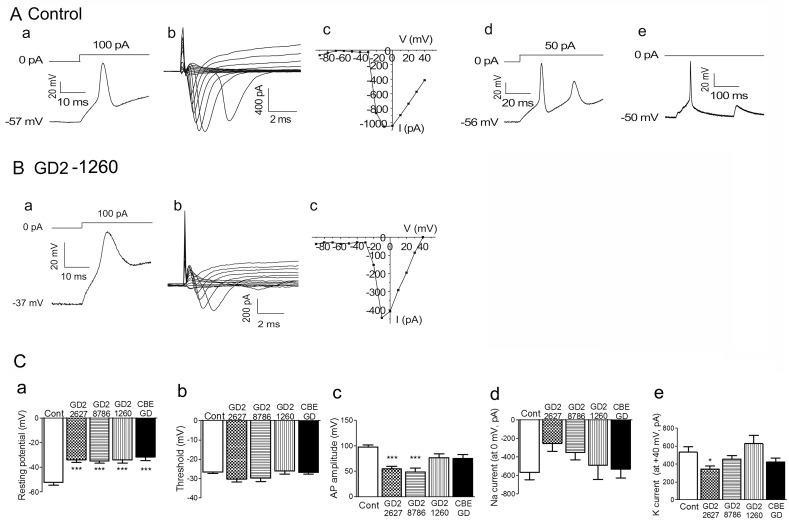
Electrophysiology of iPSC-derived neurons (14 d).(A) Action potential firing and voltage-gated sodium channels in control neurons. Control iPSC-derived neurons could fire a single action potential with membrane potential -57mV (a) or multiple action potentials (d) in response to current injection, or fire action potentials spontaneously (e). Voltage-gated sodium currents could be evoked by voltage steps (b) and the current-voltage relationship curve shows the activation of voltage-gated sodium channels (c). (B) Sample traces show membrane response to the injection of depolarizing current in GD2 iPSC-neurons. The resting membrane potentials of GD2-1260 iPSC-neurons were less negative (-37mV) although they were capable of firing action potentials (a). The voltage-gated sodium currents were smaller as shown in current trace (b) and the current-voltage relationship curve (c). (C) Action potential (AP) parameters of iPSC-neurons for control (Cont), GD2-1260, GD2-2627, GD2-8760 and CBE treated control iPSC-neurons (CBE-GD). (a) The resting membrane potential, (b) Threshold of action potentials, (c) The action potential (AP) amplitude, (d) Sodium current at the holding potential of 0 mV, (e) Potassium current at the holding potential of + 40 mV. Resting potential was significantly different between control and GD2 iPSC-neurons and CBE treated control iPSC-neurons. AP amplitudes of GD2-2627 and GD2-8760 iPSC-neurons and potassium current of GD2-2627 were reduced compared to the control. The data were from 2 to 3 independent experiments using one iPSC clone-derived neurons from each patient line (GD2-1260, GD2-2627, GD2-8760) and two iPSC clones-derived neurons from the control. Error bar represents the SEM. One-way ANOVA with Tukey's Multiple Comparison Test (* p < 0.05, ***p < 0.0001).